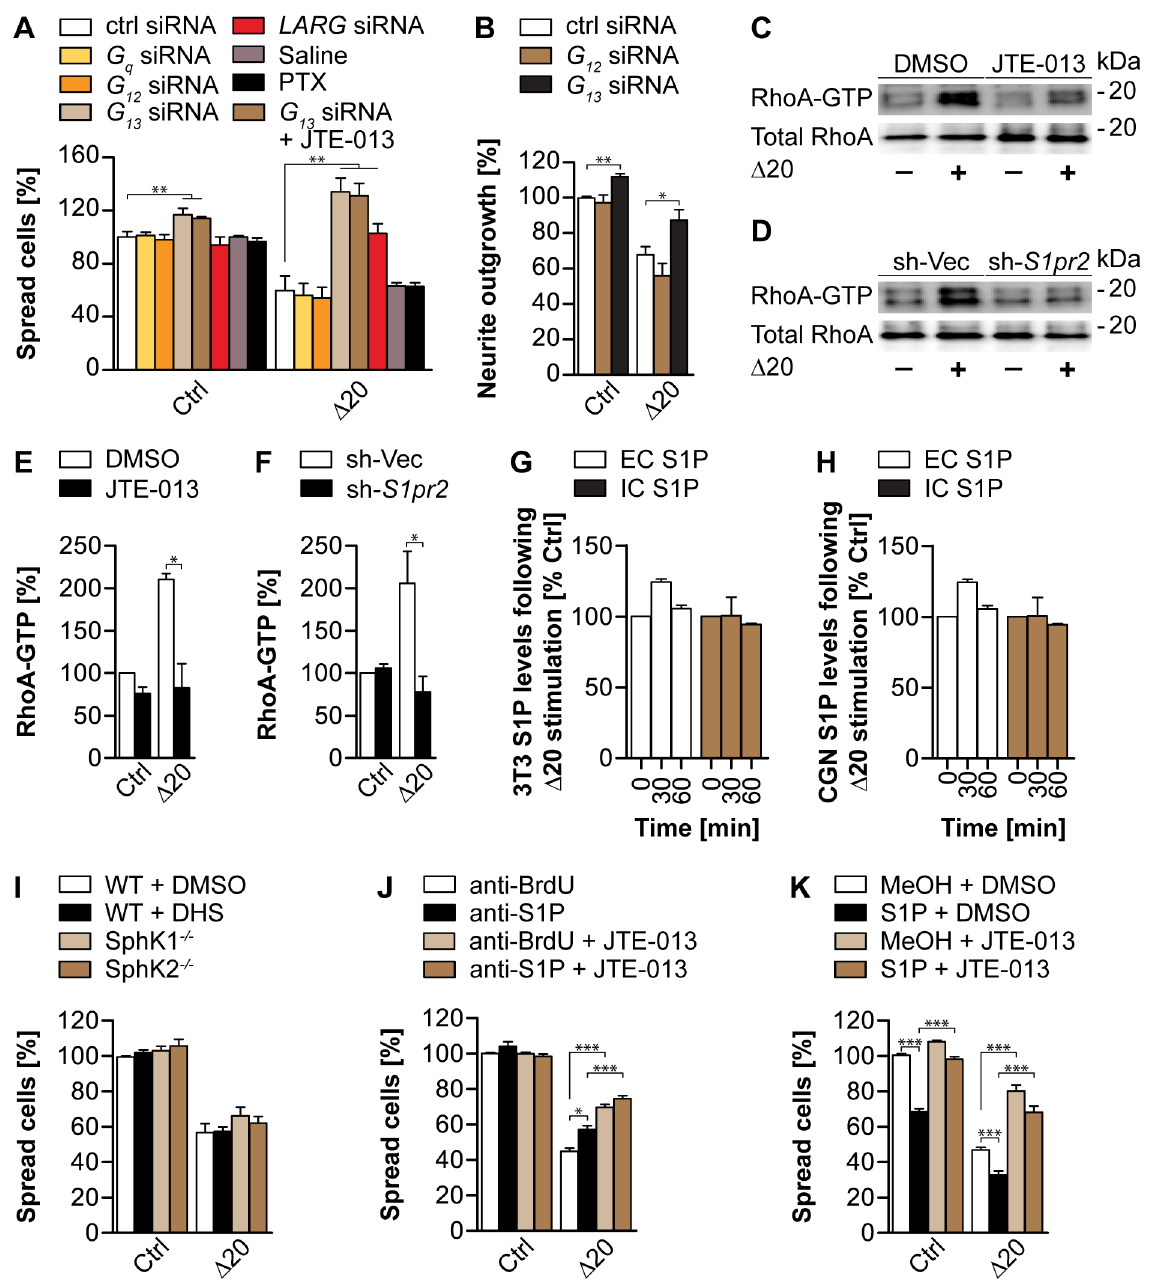
Figure 5. Nogo-A- D 20 inhibition is mediated via the G 13 -LARG-RhoA signaling axis and can be modulated by exogenous S1P. (A) 3T3 cells transfected with siRNAs against G 12 , G 13 , G q , or Larg , or control (ctrl) siRNA were replated on a Nogo-A- D 20 substrate and assessed for cell spreading. G i/o was blocked with Pertussis Toxin (PTX) for which saline was used as control. JTE-013 was co-applied to G 13 -siRNA-treated cells to investigate a cumulative effect. (B) Transfection of DIV4 E19 cortical neurons with siRNA against G 13 but not G 12 similarly rescued Nogo-A- D 20- induced neurite outgrowth inhibition. (C,D) Nogo-A- D 20-induced RhoA activation was assessed in JTE-013- versus DMSO-treated cells (C) or in cells carrying a stable knockdown of S1PR2 (sh- S1pr2 ) versus control vector (sh-Vec) (D). (E,F) Relative quantification of (C) and (D), respectively. (G,H) Competitive ELISA quantifications of extra- (EC) and intracellular (IC) S1P levels in 3T3 cells (G) and cerebellar granule neurons (H) before and after 30 and 60 min incubation with Nogo-A- D 20. (I) Quantification of Nogo-A- D 20-mediated cell spreading inhibition in the presence of the SphK-specific blocker D,L- threo -dihydrosphingosine (DHS) or in SphK1 2 / 2 or SphK2 2 / 2 MEFs. (J,K) 3T3 cells were plated on a Nogo-A- D 20 substrate in the presence of the function blocking anti-S1P antibody Sphingomab (J) or of exogenous S1P (K) and assessed for cell spreading. Co-application of JTE-013 significantly reversed the modulatory effects obtained by S1P (K) but not anti-S1P (J). Anti-BrdU antibody or methanol was used as control in (J) and (K). Data shown are means 6 SEM ( n =3–6 experiments; * p , 0.05, ** p , 0.01, *** p , 0.001).